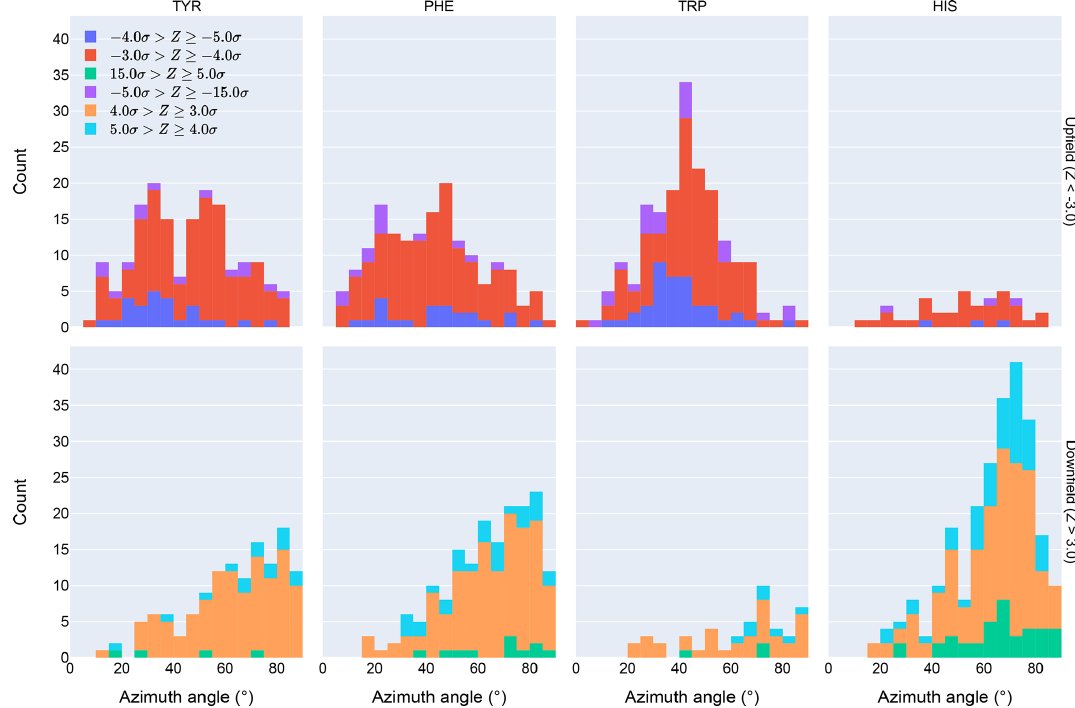
Figure 4. Distribution of azimuth angles for outlier ( > 3 σ ) amide proton shifts. Upfield shifts are shown in the top row, downfield shifts in the bottom